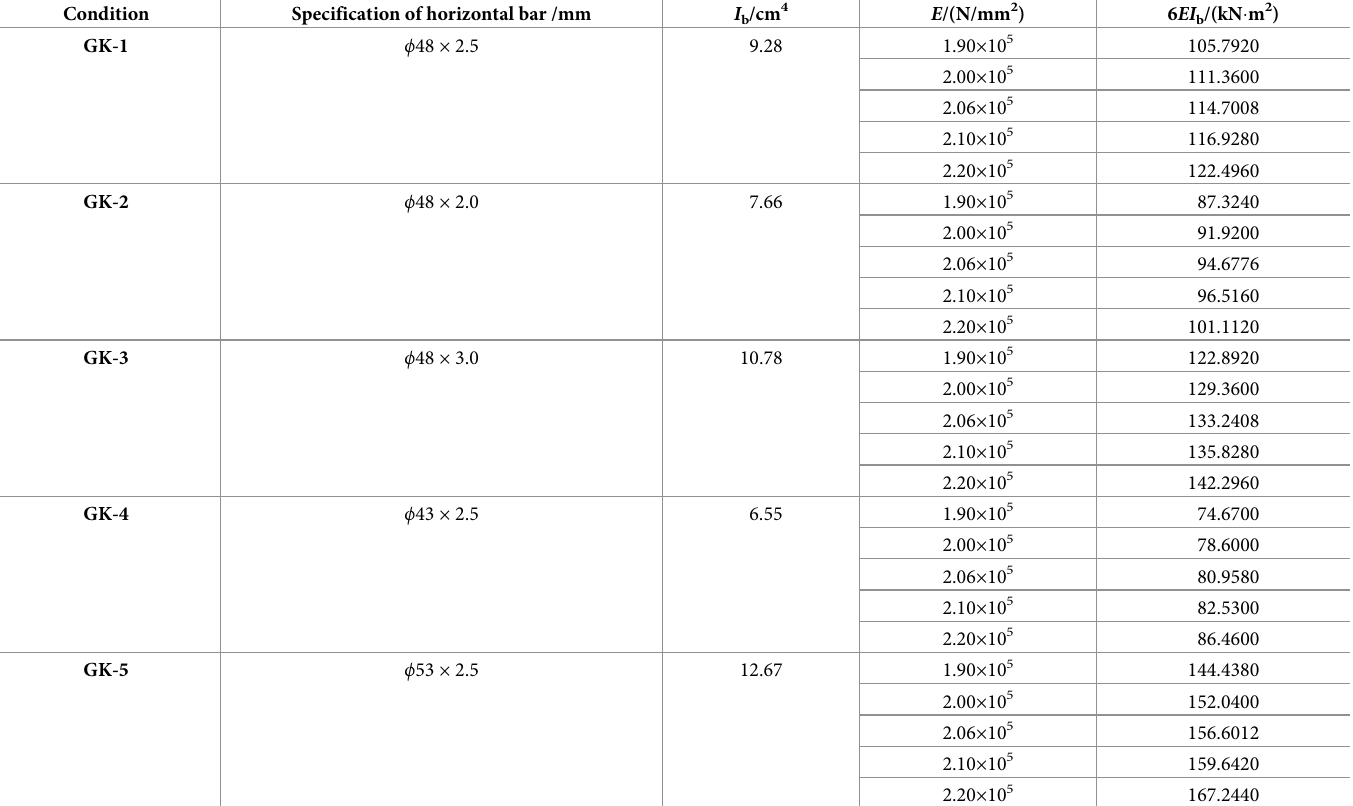
Table 10. Influence parameters of elastic modulus of vertical pole with specification ϕ 48 ×